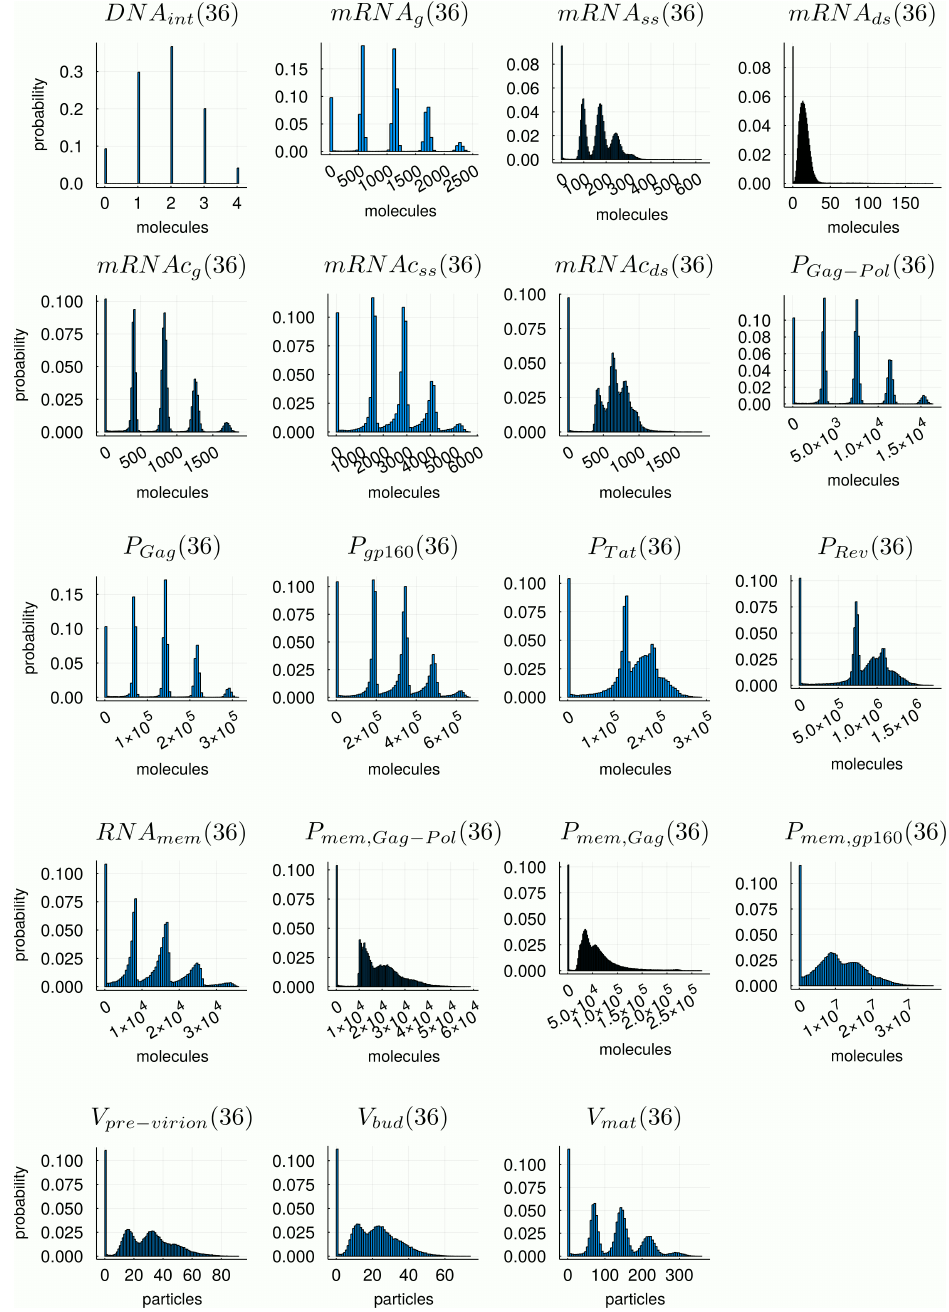
Figure 5. Histograms of the stochastic model variables at t = 36 h for the initial condition [ V free ]( 0 ) =